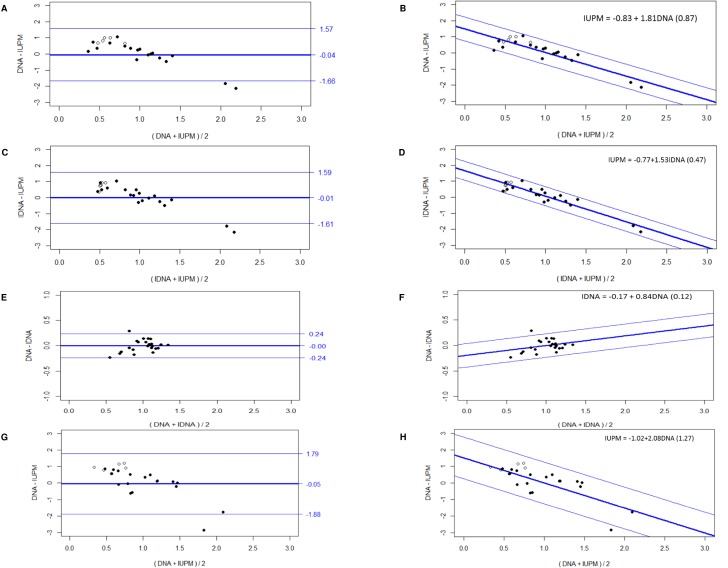
Bland Altman analysis.Agreement for HIV-1 copies quantification between: A) Total HIV-1 DNA (IDNA) and IUPM, mean difference (log 10) and 95% Limits of agreement; B) Slope-intercept equation for total HIV-1 DNA and IUPM; C) Integrated HIV-1 DNA (DNA) and IUPM, mean difference (log 10) and 95% Limits of agreement; D) Slope-intercept equation for integrated HIV-1 DNA and IUPM; E) Total HIV-1 DNA (DNA) and integrated HIV-1 DNA (IDNA), mean difference (log 10) and 95% Limits of agreement; F) Slope-intercept equation for total and integrated HIV-1 DNA; G) Total HIV-1 DNA (DNA)–time point 1 and IUPM–time point 2, mean difference (log 10) and 95% Limits of agreement; and H) Slope-intercept equation for total HIV-1 DNA–time point 1 and IUPM–time point 2. *Of note: Open label symbol represent test results below the detection threshold for VOA.